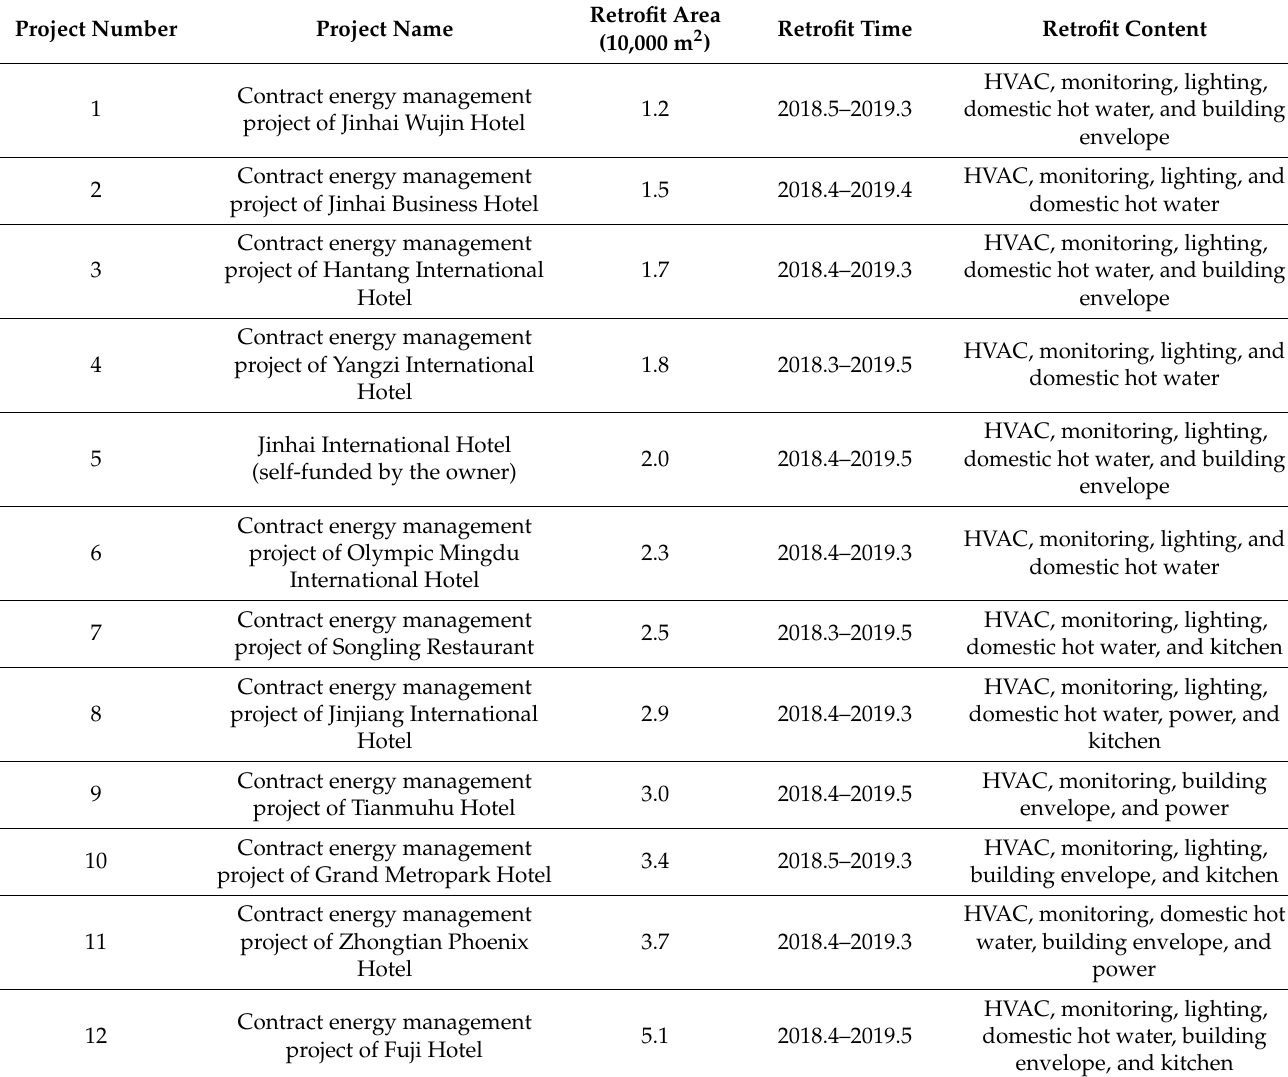
Table 1. Basic information of energy-saving retrofit projects of existing